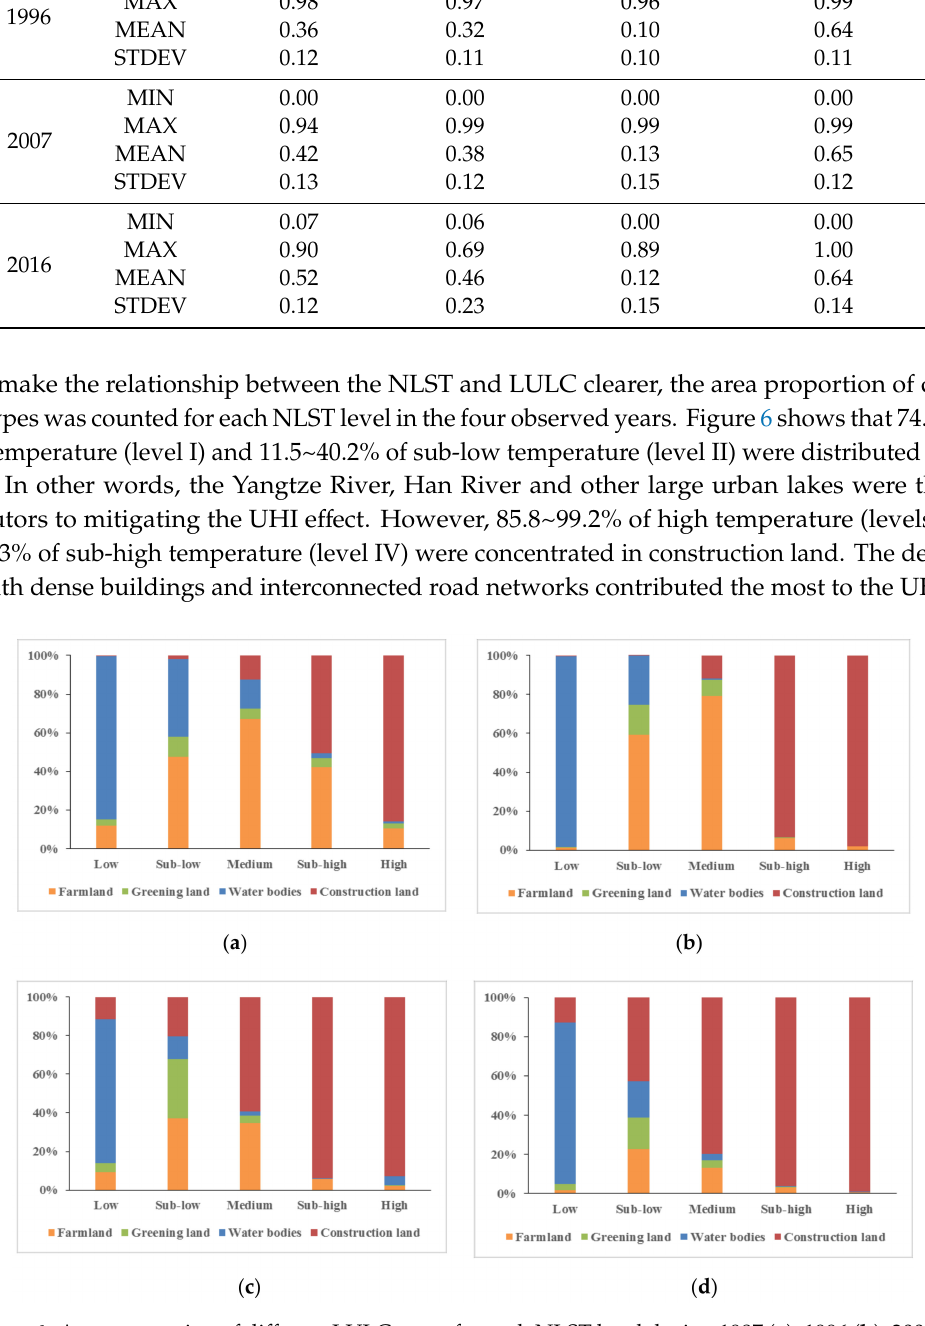
Figure 6. Area proportion of di ff erent LULC types for each NLST level during 1987 ( a ), 1996 ( b ), 2007 ( c ) and 2016 ( d